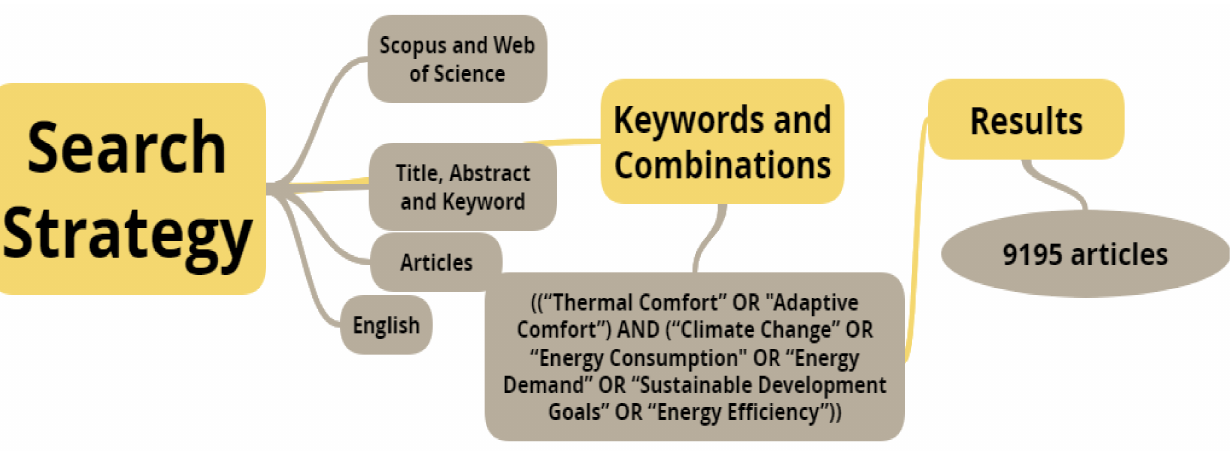
Figure 2. Results obtained through the database search